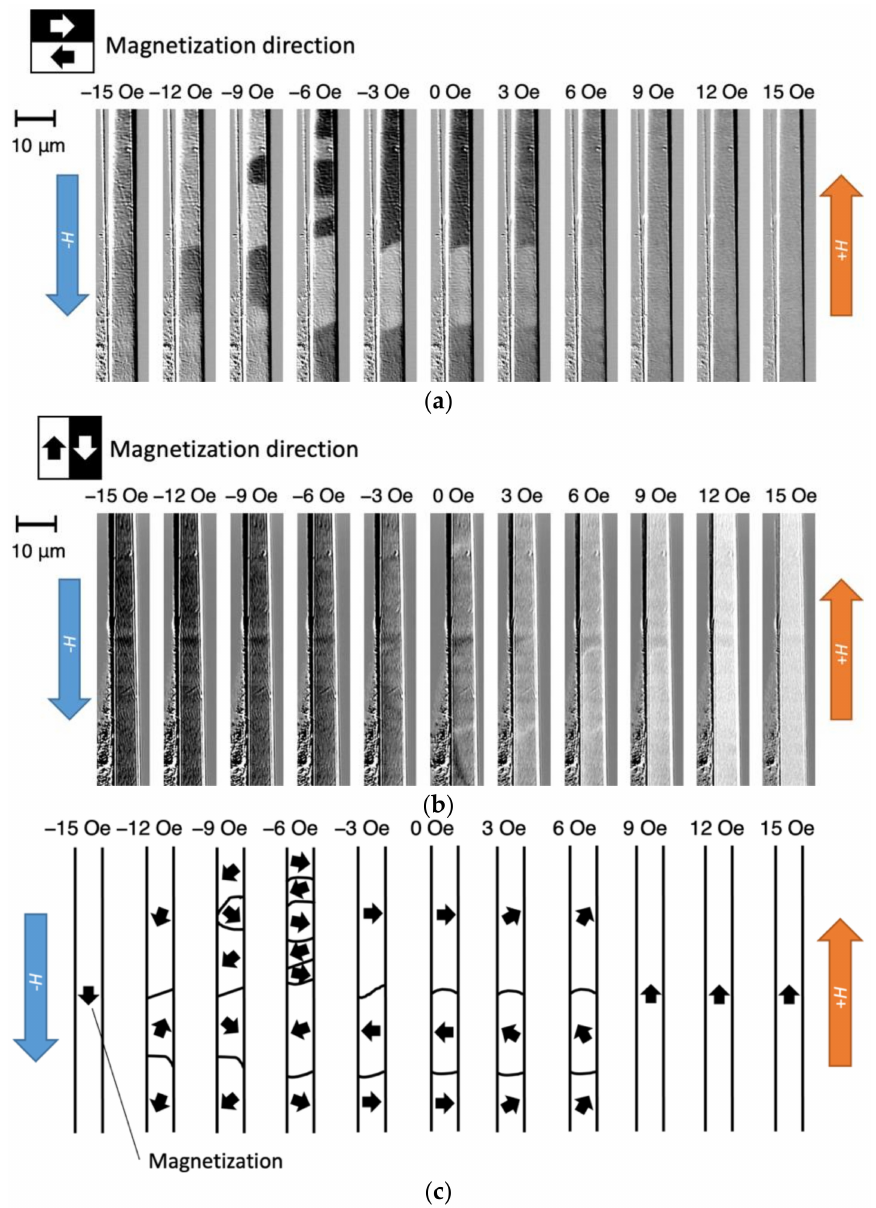
Figure 3. Application of an external magnetic field in the axial direction around 700 to 800 µ m from the left-hand end of the wire shown in Figure 2: ( a ) radial magnetic domain pattern; ( b ) axial magnetic domain pattern; ( c ) and inferred magnetization